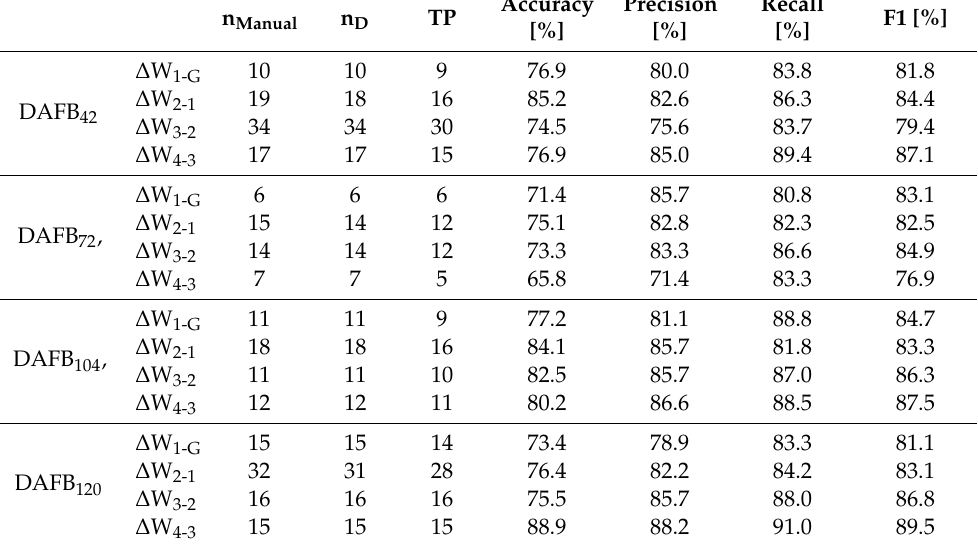
Table 2. Performance assessment of the localization algorithm on the segmented apple points in foliated trees (T L ) considering the apple in defoliated trees (T D ) as ground truth over four growth stages given in days after full bloom (DAFB) and in four tree height (W) starting from ground (G) till the maximum tree point (4). Manually counted fruit number (n Manual ), total number of detected fruits in T D (n D ) and true positives (TP) in T L with descriptive statistics are given. n Manual n D